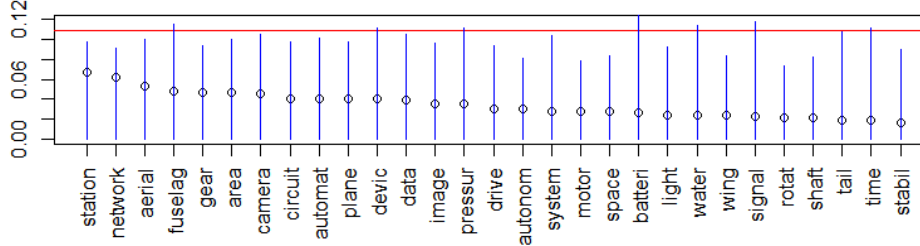
Figure 13. Variable importance results of explanatory keywords. Table 7. Technology scenarios for